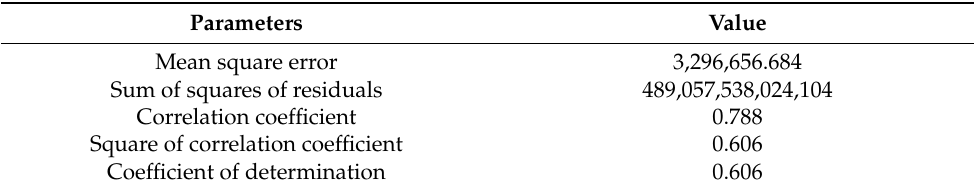
Table 3. Relevant parameters of optimal function relation equation.